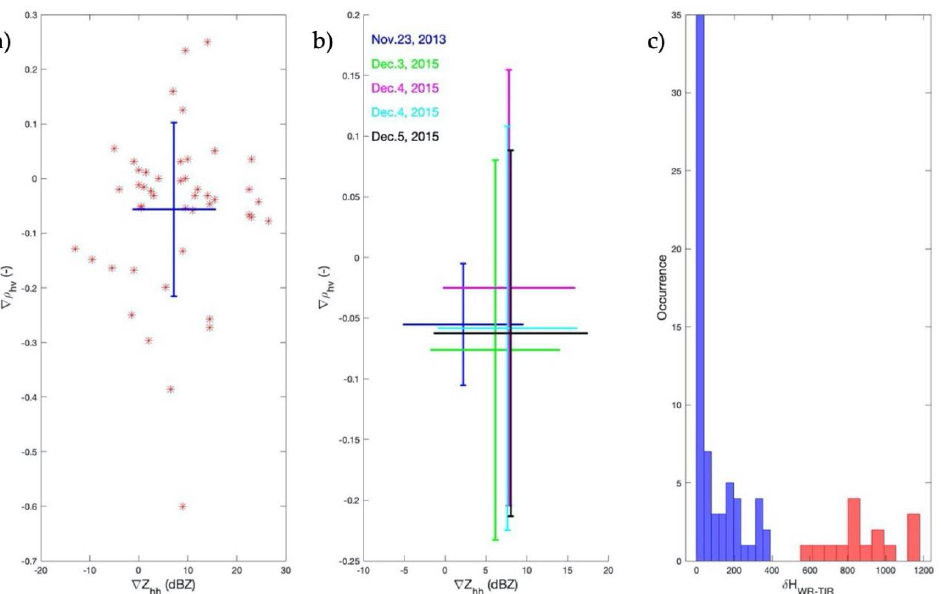
Figure 9. Panel ( a ) shows the scatterplot of the reflectivity factor vertical gradient ∇ Z hh and copolar correlation coe ffi cient vertical gradient ∇ ρ hv for all analyzed events with the horizontal and vertical bars delimiting the dispersion of gradients. In panel ( b ) the dispersion bar of ∇ Z hh and ∇ ρ hv related to five eruptive events are plotted in di ff erent colors, whereas panel ( c ) is the histogram of di ff erence between the H IJR derived from X-band radar and the TIR camera for both Etna events. Red bars refer in panel ( c ) to the cases where TIR camera is obscured by clouds. The comparison of the results, obtained for the event of 23 November 2013 and 3–5 December 2015, shows a promising agreement. Our comparative analyses of the polarimetric radar measurements provides estimates of the IJR heights. Here, we might validate the use of such heights to retrieve first order estimates of MER during paroxysms at Etna [20,25,30]. Indeed, MER can be derived using the area of the eruptive vent, the magma-gas mixture density and the exit velocity (surface flux approach in [25]). If we consider the IJR height as a proxy for the height of the lava fountain [22,23,27], it can then be related to an exit velocity v ex through the well-known Torricelli equation for a non-viscous ballistic flow [25–27]. When making this assumption, it is, however,